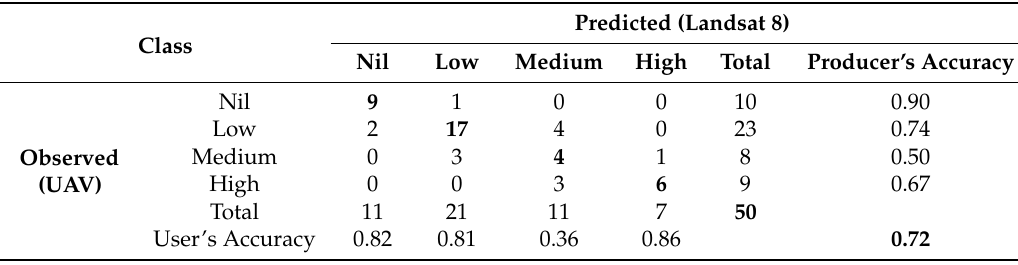
Table 5. Confusion matrix of a threshold classification using 50 pixel values of dMSI predicted from Landsat 8 in reference to four classes observed from UAV.